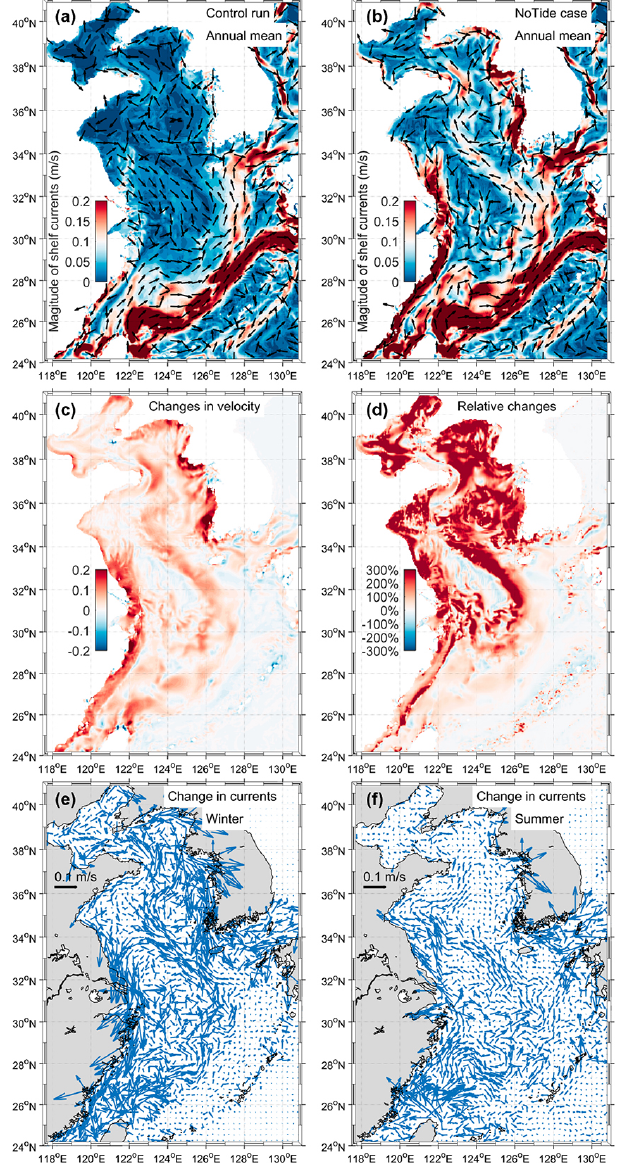
Figure 10. Comparison of the shelf currents between the control run and no-tide case. (a) and (b) are the annual mean and vertically av- eraged velocities for the control run and no-tide case, respectively. The arrow and color in (a) and (b) denote the direction and magni- tude of the velocity, respectively. (c) and (d) show the change and relative change in the magnitude of the shelf currents after remov- ing tides in the model. (e) and (f) show the changes in shelf currents in February and August,